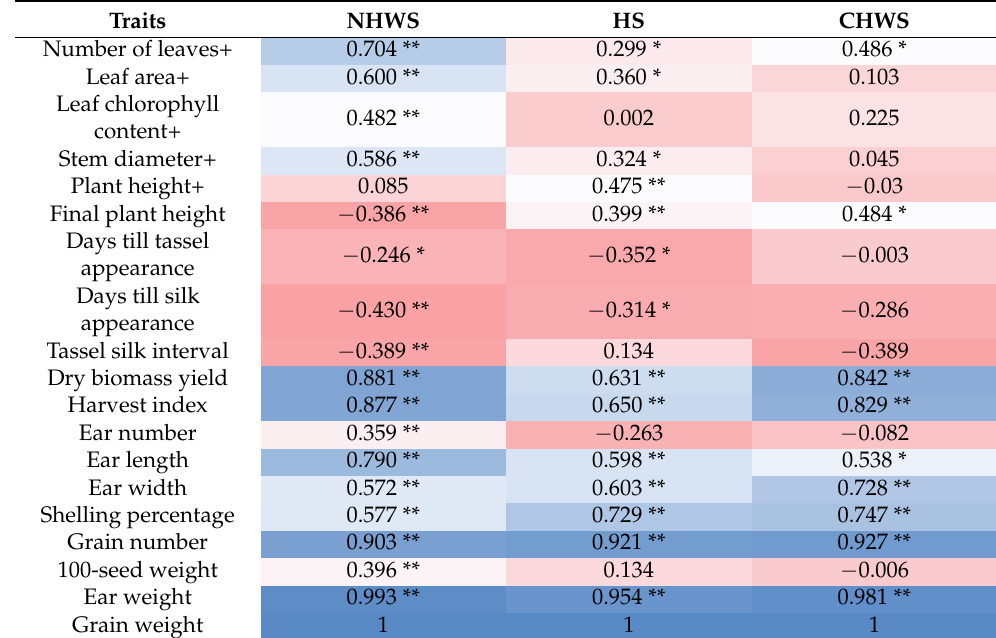
Table 1. The grain weight correlation coefficient with other maize growth and yield traits under various stress conditions.